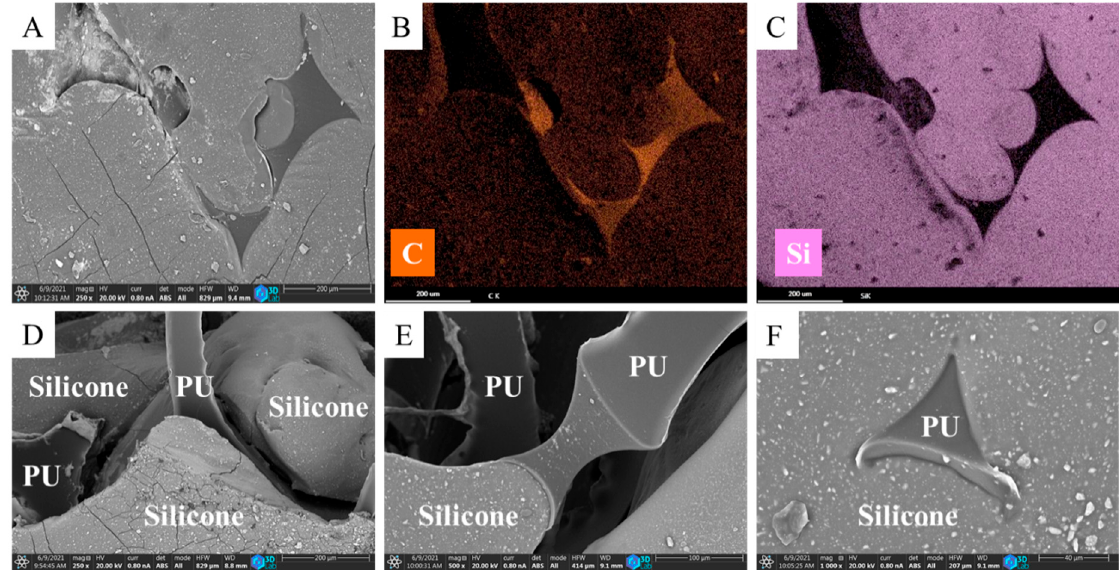
Figure 3. SEM images of the N-BCNT/PU-silicone rubber sample ( A ), element maps of the carbon from the PU matrix ( B ) and the silicone of the silicone rubber ( C ). Highlighted areas of the silicone rubber and PU in the N-BCNT/PU-silicone rubber sample ( D – F ).